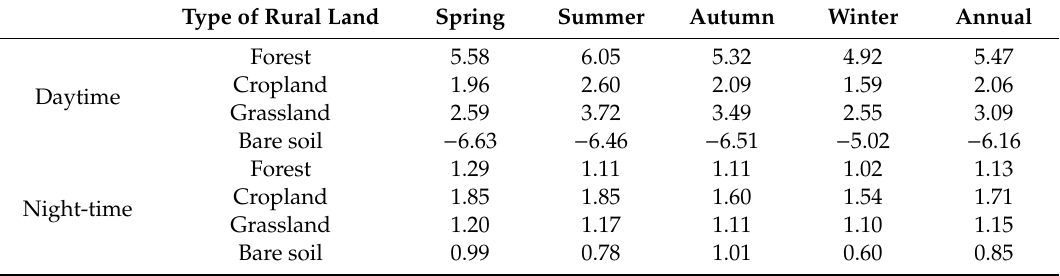
Table 3. The diurnal and seasonal SUHII ( ◦ C) in South America for di ff erent types of rural